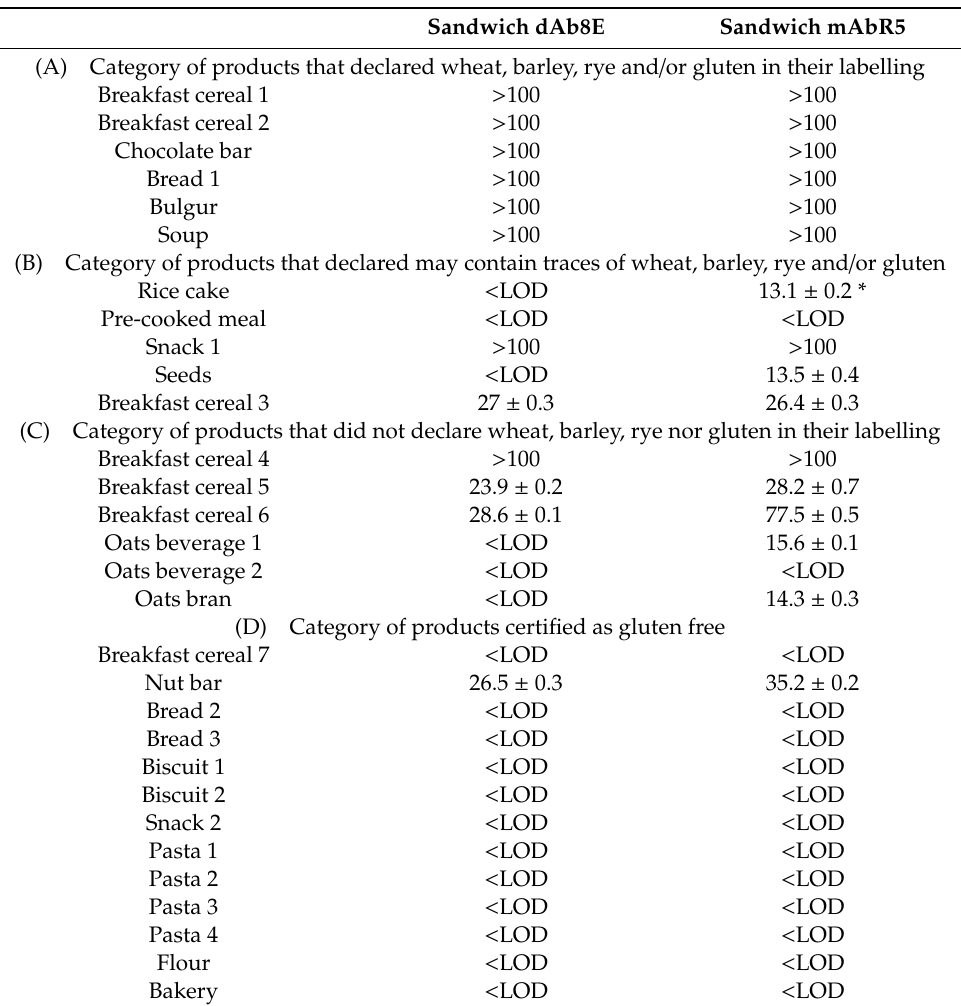
Table 1. Comparison of the results obtained for the detection of gluten in the analysis of 30 commercial food products using the developed sandwich-dAb8E enzyme-linked immunosorbent assay (ELISA) and the o ffi cial method based on mAbR5